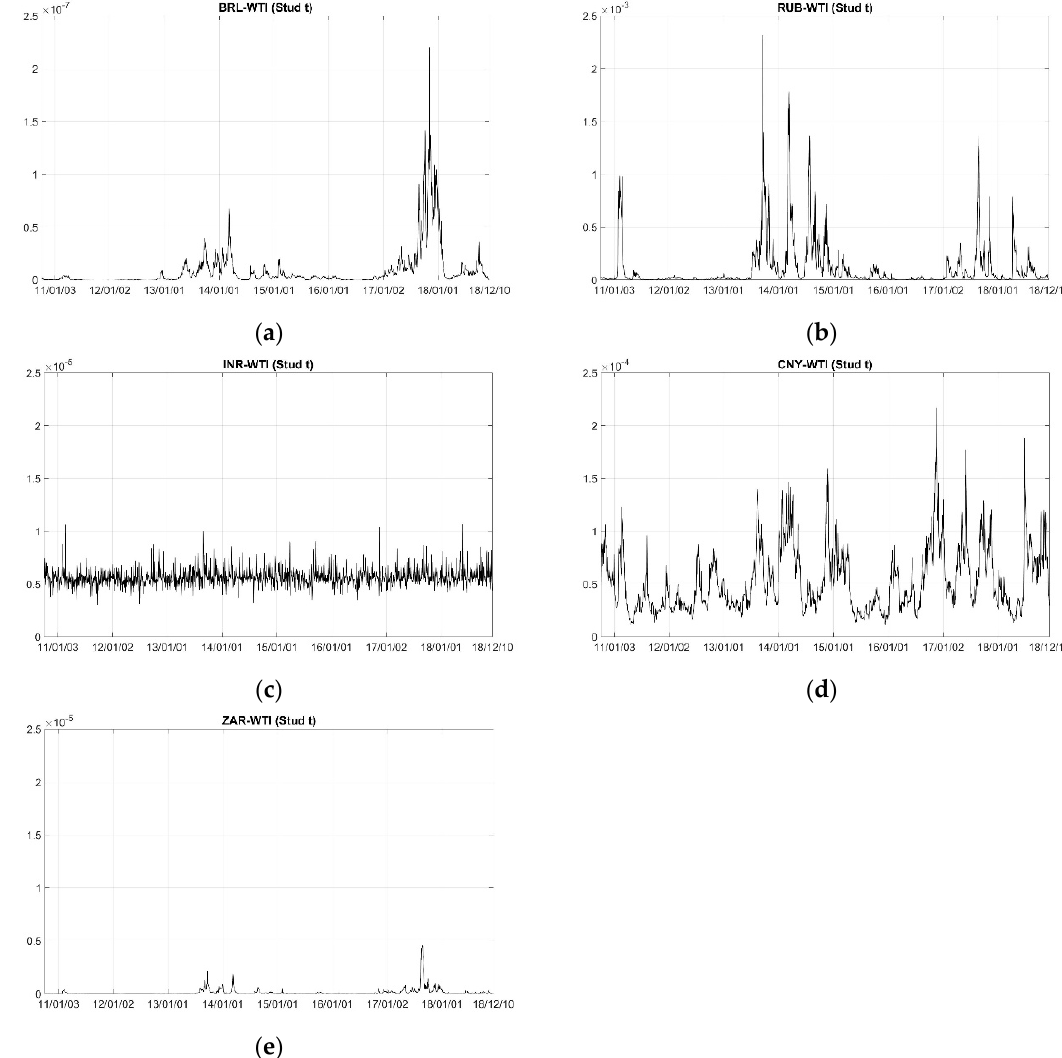
Figure 3. Conditional tail dependence from the time-varying copula models. ( a – e ) refer to pair of BRL–WTI, RUB–WTI, INR–WTI, CNY–WTI and ZAR–WTI, respectively.